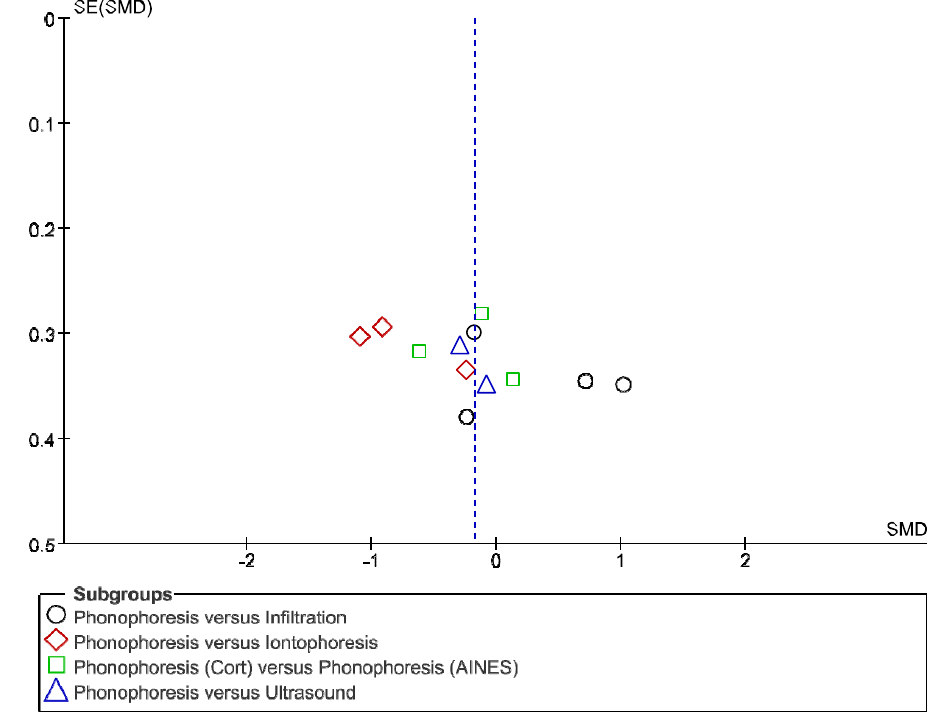
Figure 18. Phonophoresis for LMMotor.